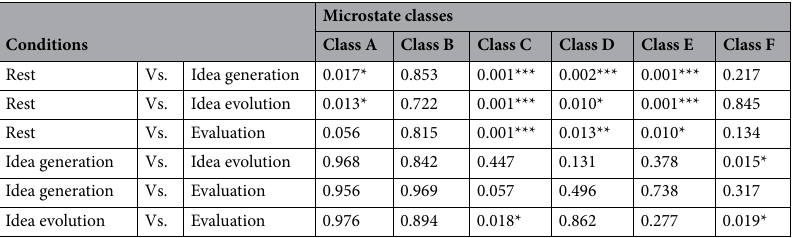
Table 3. Paired t-test p-values for microstate coverage between conditions. * ρ < 0.050 , ** ρ < 0.010 , *** ρ < 0.005 .